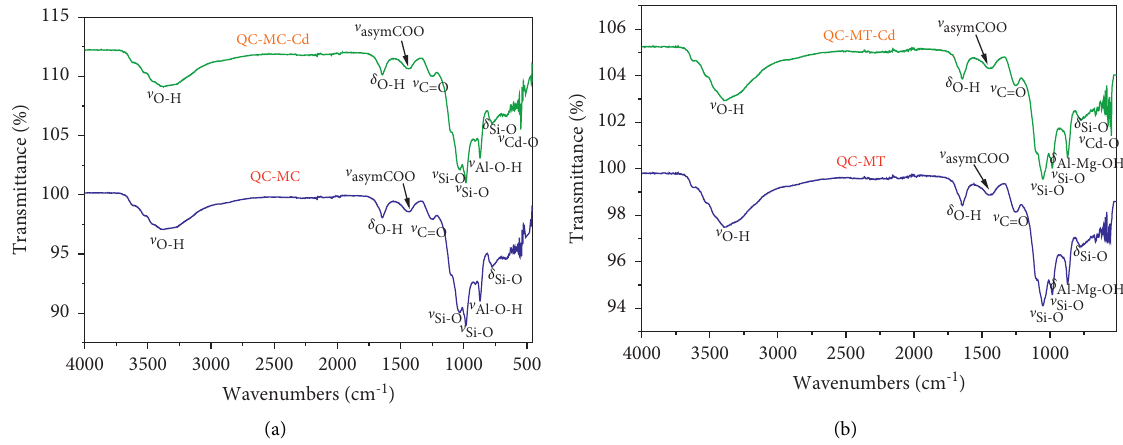
Figure 13: FTIR spectra before and after adsorption of Cd (II) by (a) QC-MC and (b) QC-MT.